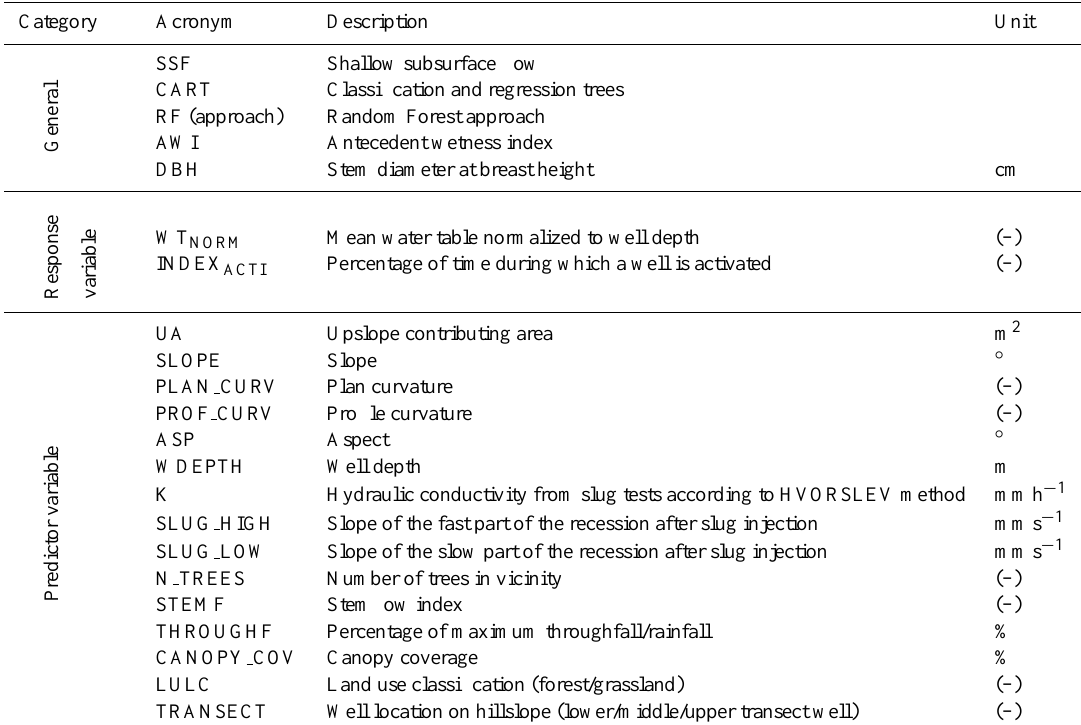
Table 1. List of acronyms. For details about the determination of the response and predictor variables see methods section.